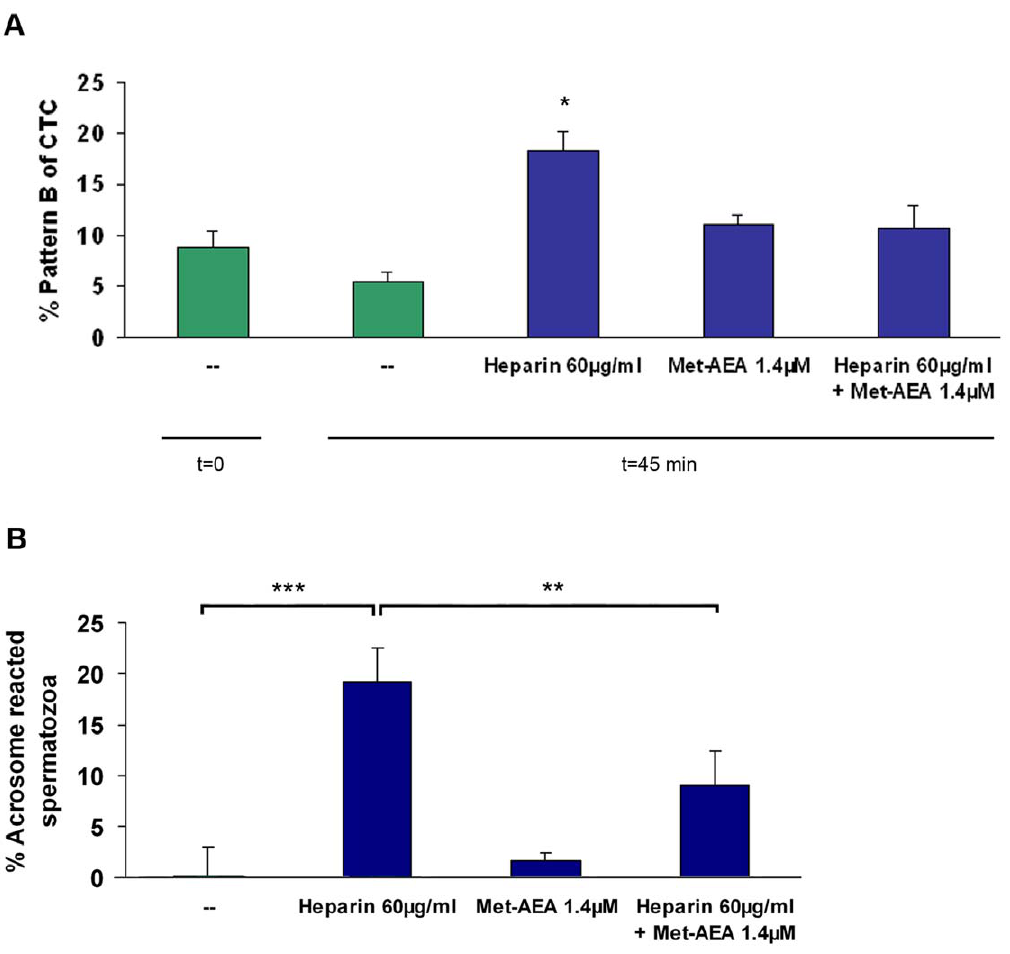
Figure 2. Effect of micromolar concentration of Met-AEA on bull heparin-induced sperm capacitation. Spermatozoa were incubated for 45 min at 38.5 u C in sp-TALP medium with heparin, Met-AEA (1.4 m M) or Heparin + Met-AEA (1.4 m M). Bars indicate the percentage of capacitated spermatozoa (A: % pattern B of CTC; B: % acrosome reacted spermatozoa). Data are expressed as mean 6 SEM. A : Assessment of sperm capacitation by CTC assay. (—) t=0 and t=45, sp-TALP at 0 and 45 min (control) incubation respectively (n=4). *p , 0.05 vs control and Heparin (60 m g/ml) + Met- AEA (1.4 m M). B : Assessment of sperm capacitation by acrosome reaction evaluated by PSA-FITC; (—) t=45 (control) (n=4). ***p , 0.001 vs control; **p , 0.01 vs Heparin (60 m g/ml) + Met-AEA (1.4 m